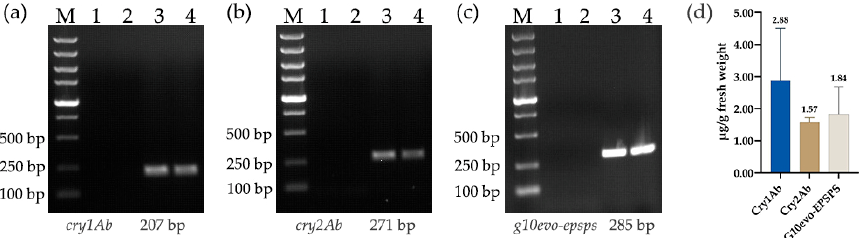
Figure 2. Identification of exogenous genes in GM maize ZDAB3 grain. ( a ) RT-PCR detection of the exogenous gene cry1Ab . Lane M: DL 5000 DNA Marker; Lane 1–2: non-GM maize; Lane 3–4: GM maize ZDAB3. ( b ) RT-PCR detection of the exogenous gene cry2Ab . Lane M: DL 5000 DNA Marker; Lane 1–2: non-GM maize; Lane 3–4: GM maize ZDAB3. ( c ) RT-PCR detection of the exogenous gene g10evo-epsps . Lane M: DL 5000 DNA Marker; Lane 1–2: non-GM maize; Lane 3–4: GM maize ZDAB3. ( d ) Protein levels of Cry1Ab, Cry2Ab, and G10evo-EPSPS in ZDAB3